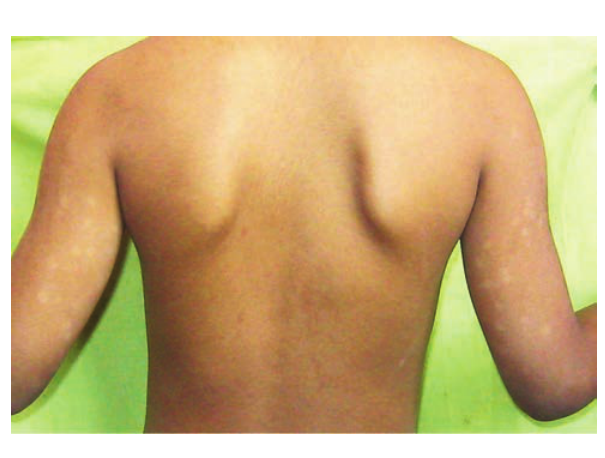
Figure 4. Eruptive hypomelanosis is a recently reported paravi- ral exanthem with round or oval hypopigmented patch seen after a prodromal phase. The commonest sites are extensor sur- faces of the limbs, as seen in this child with lesions at extensor aspects of bilateral